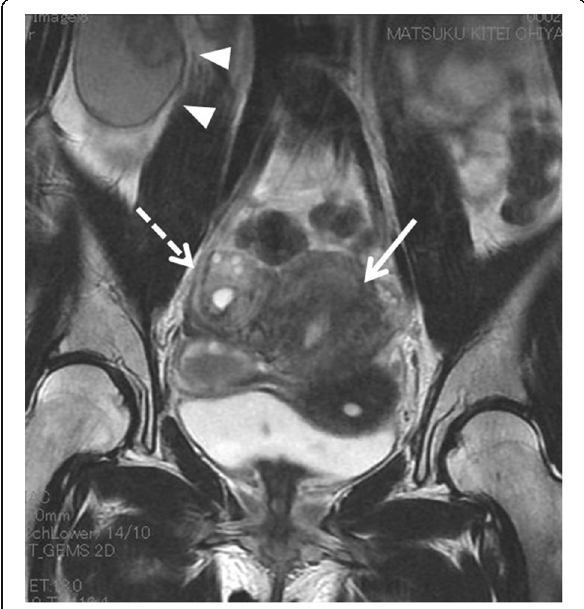
Fig. 2 MRI demonstrates a cystic mass of iso-intensity on T1-weighted and high intensity on T2-weighted images (arrow heads), uterine fibroids (arrow), and cystic masses at the right ovary (broken